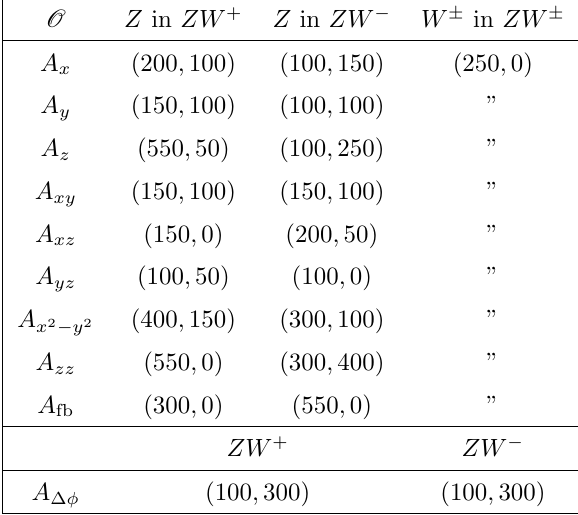
3 l , p T ( Z )) for various asymmetries